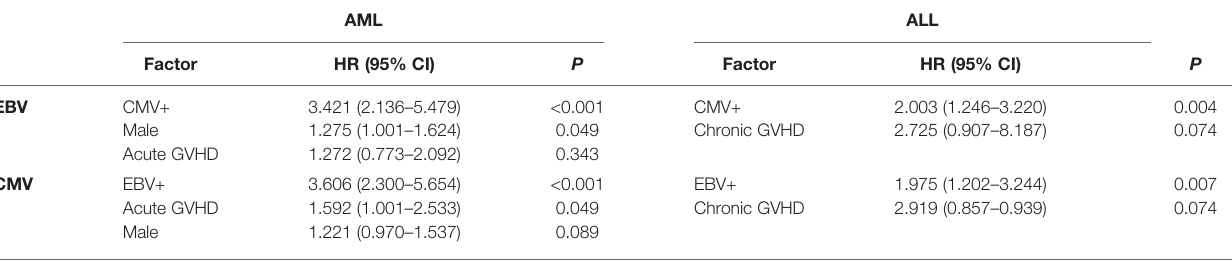
TABLE 2 | Multivariate Cox regression model for EBV reactivation and CMV reactivation.